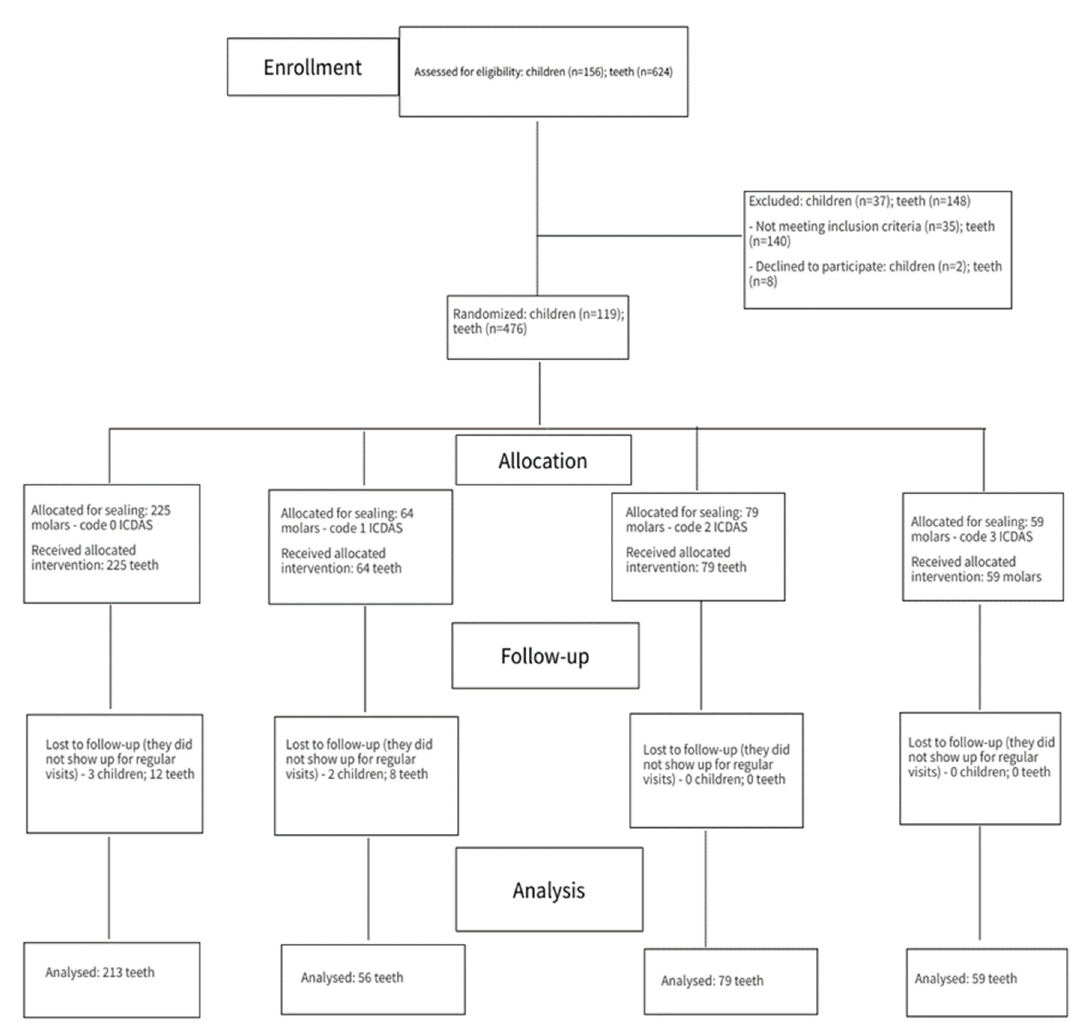
Figure 1. Consort flow diagram for the study.